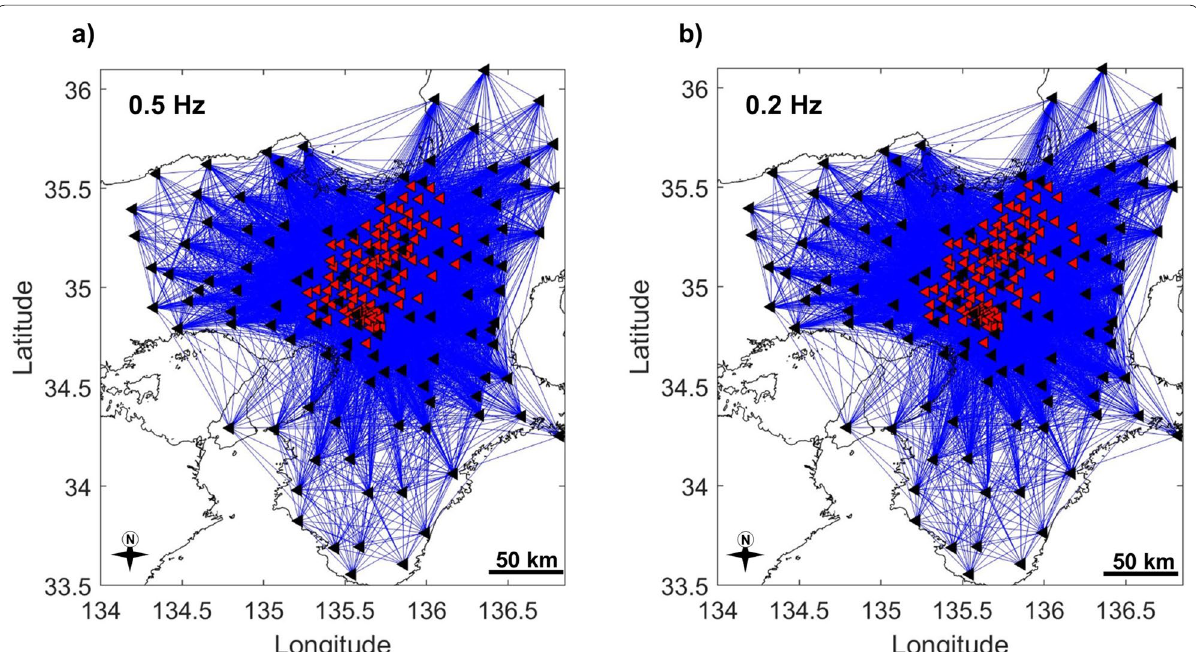
Fig. 5 Ray paths derived from the inversion model at two selected frequencies: a 0.5 Hz and b 0.2 Hz. Also shown are the locations of permanent seismic stations (black triangles) and temporary seismic stations (red triangles). Blue lines indicate ray